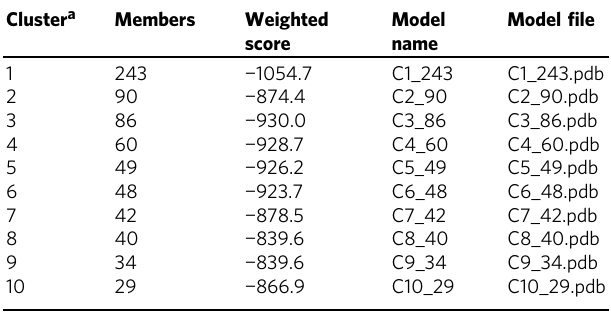
Table 1 ClusPro bimolecular docking of Fbxo4 with